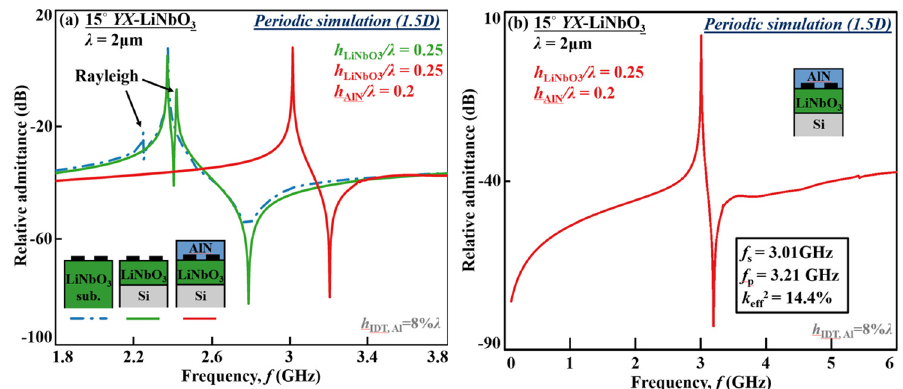
Figure 12. FEM-simulated ( a ) narrow-band response based on AlN/LiNbO 3 /Si ( h LiNbO3 / λ = 0.25, h AlN / λ = 0.2) compared to LiNbO 3 /Si ( h LiNbO3 / λ = 0.25) and Si substrate; and ( b ) wide-band response based on AlN/LiNbO 3 /Si ( h LiNbO3 / λ = 0.25, h AlN / λ = 0.2) for the nonleaky SH resonators with periodic structure (1.5D model).